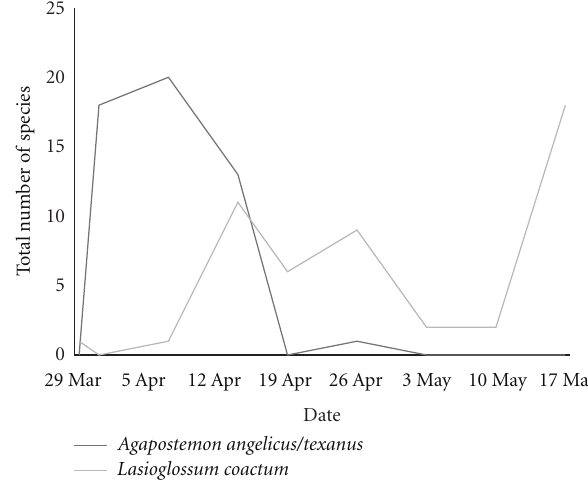
Figure 1: Seasonality of Agapostemon angelicus/texanus and Lasio- glossum coactum collected from three Lower Rio Grande Valley watermelon fields during